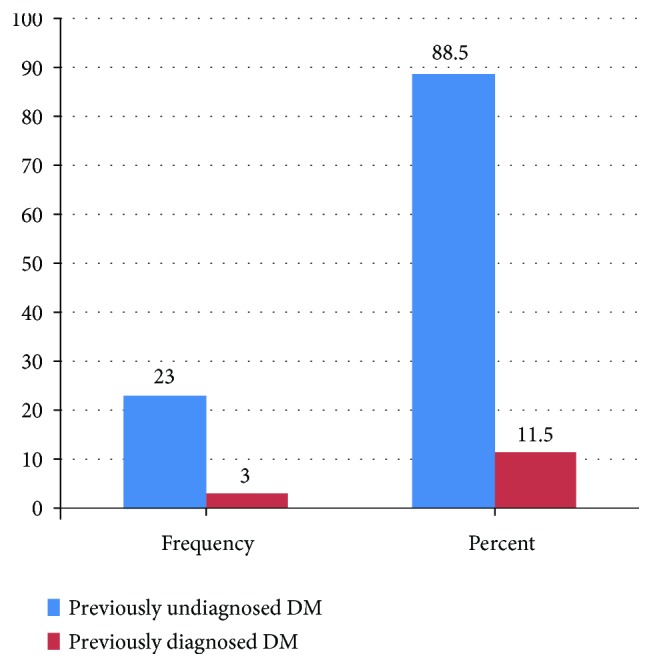
Distribution of previously diagnosed and undiagnosed DM among DM-positive participants, in Mizan-Aman town, southwest Ethiopia, 2016.